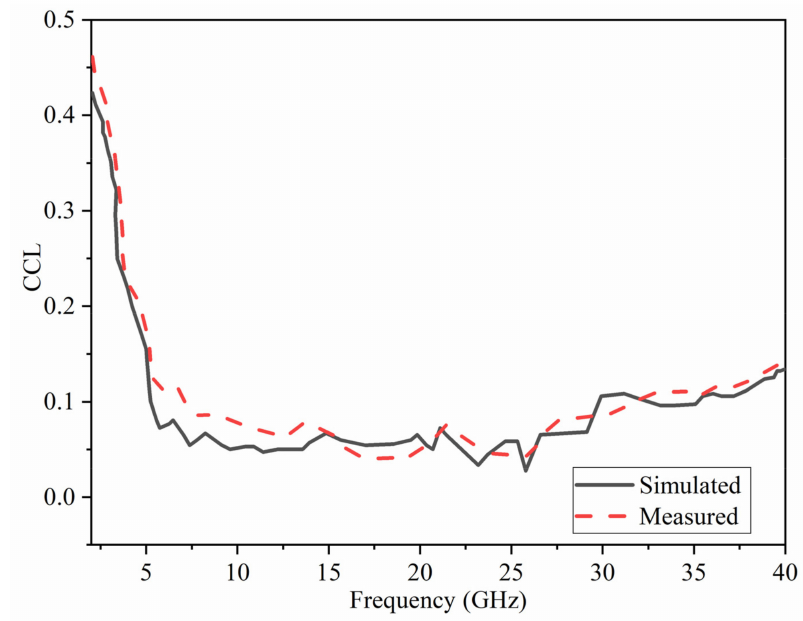
Figure 23. Simulated and Measured performance for the channel capacity loss